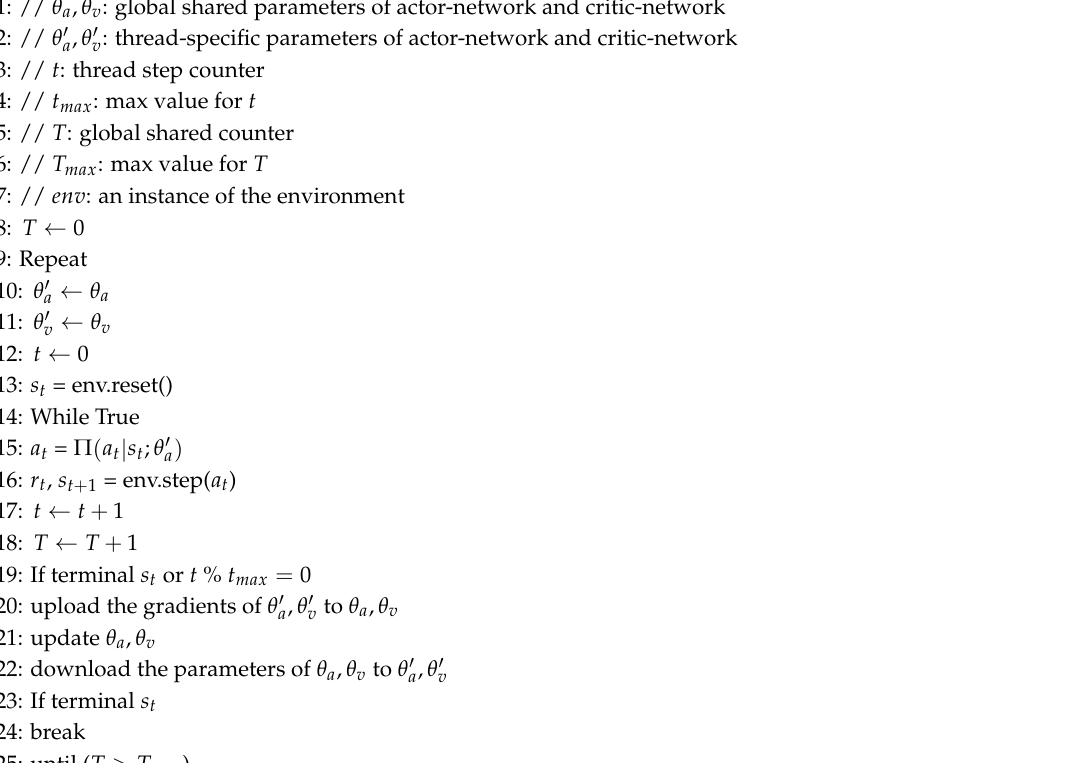
Algorithm 1. Pseudo-code of each actor-learner in Asynchronous Advantage Actor-Critic